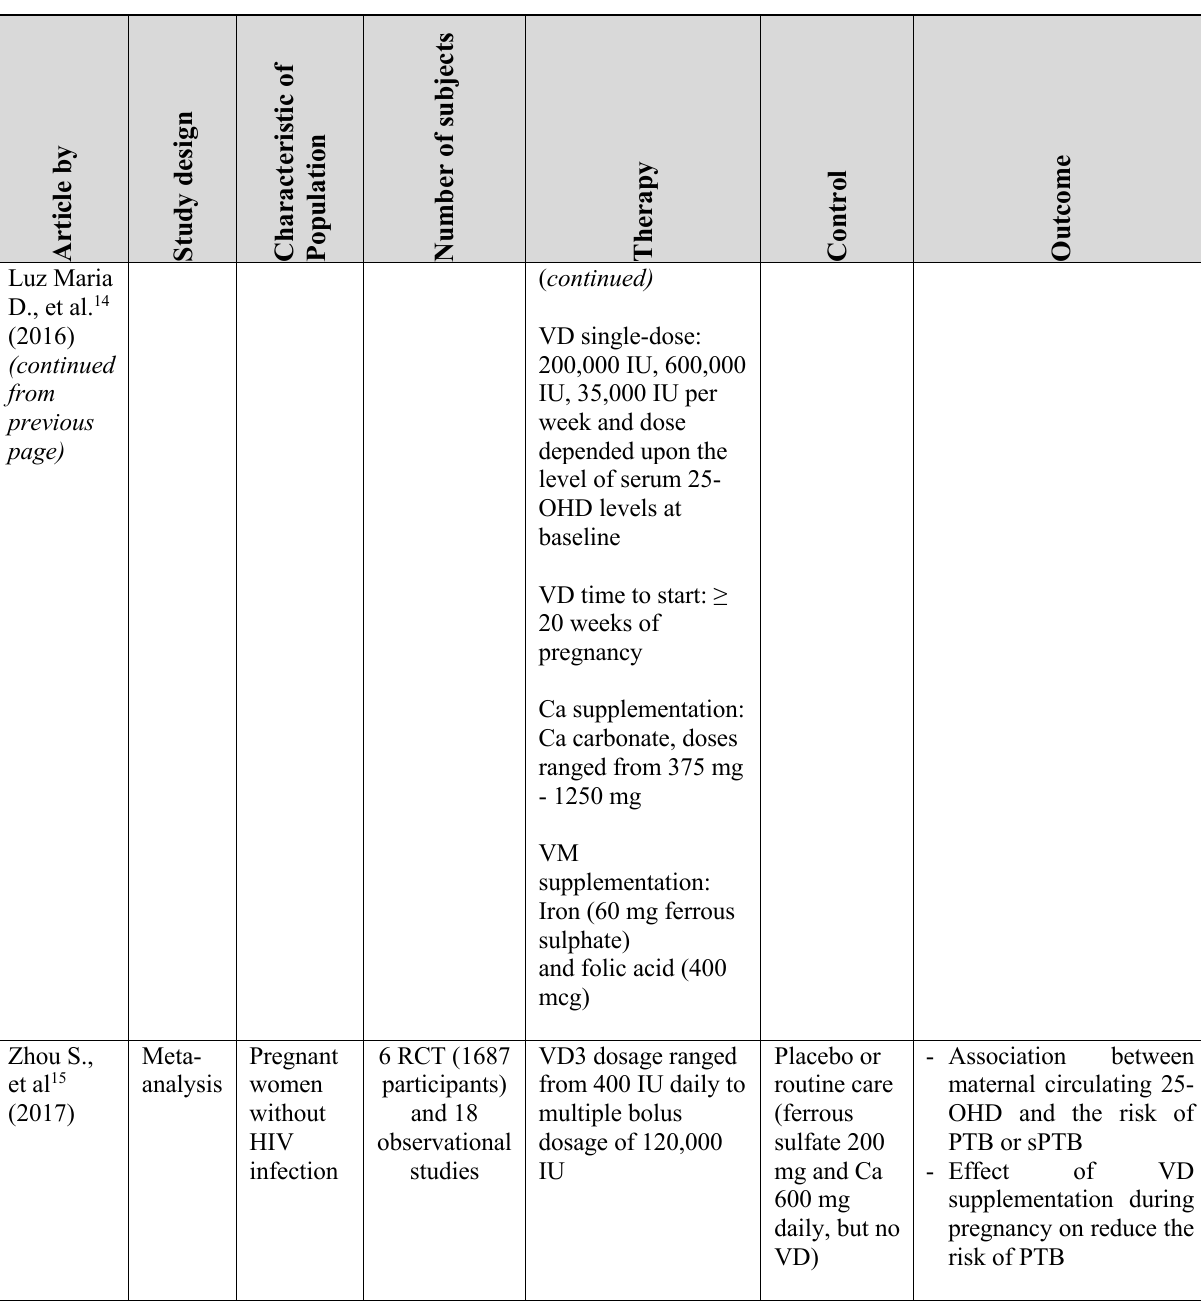
Table 2 . Characteristics of study